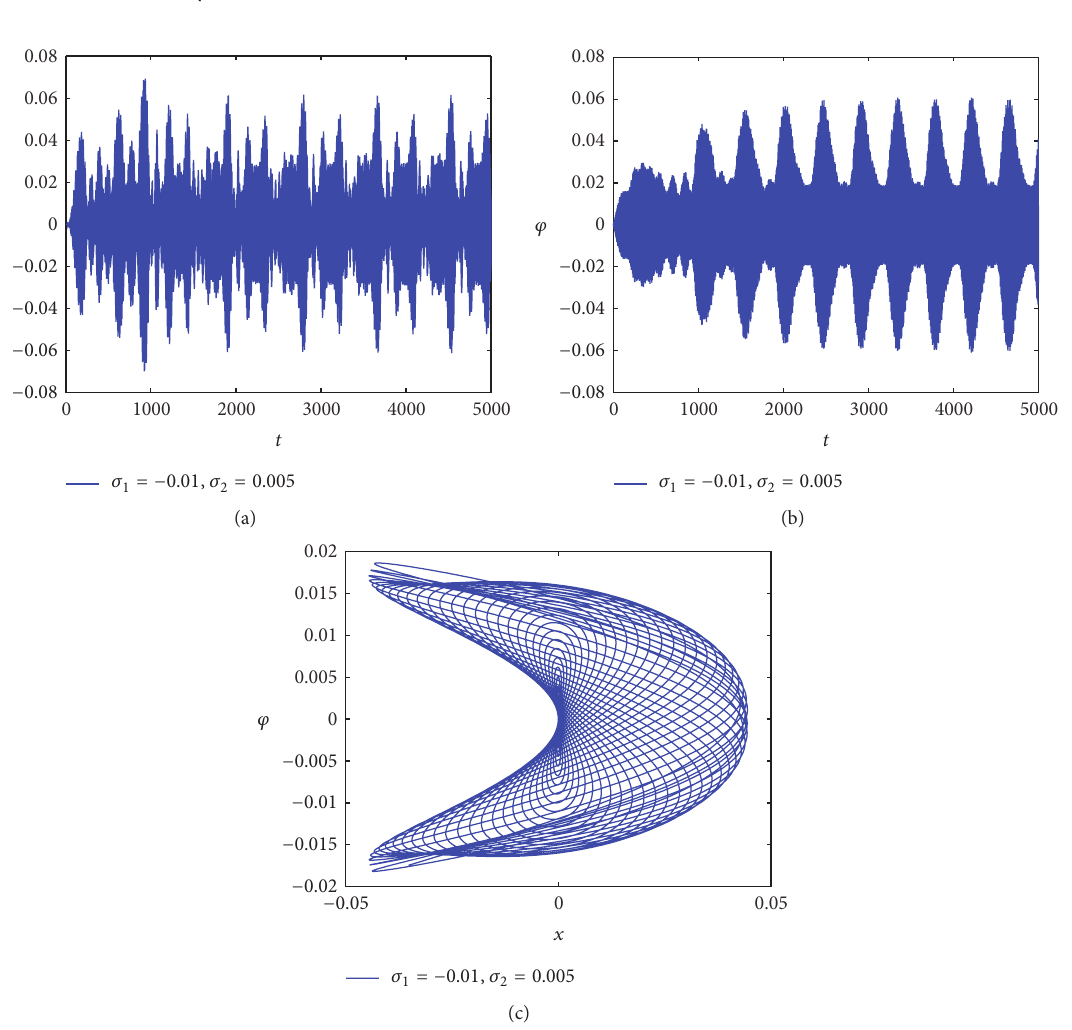
Figure 15: Parts (a) and (b) show the portraits of time history, while part (c) represents the variation of the solution 𝑥 versus the solution 𝜑 when 𝑎 = 0